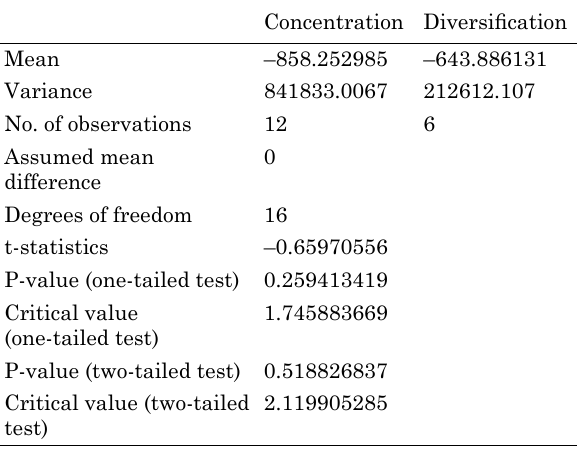
Table 9. Results of t-test between average EVA of property-concentrated and multi-functional companies